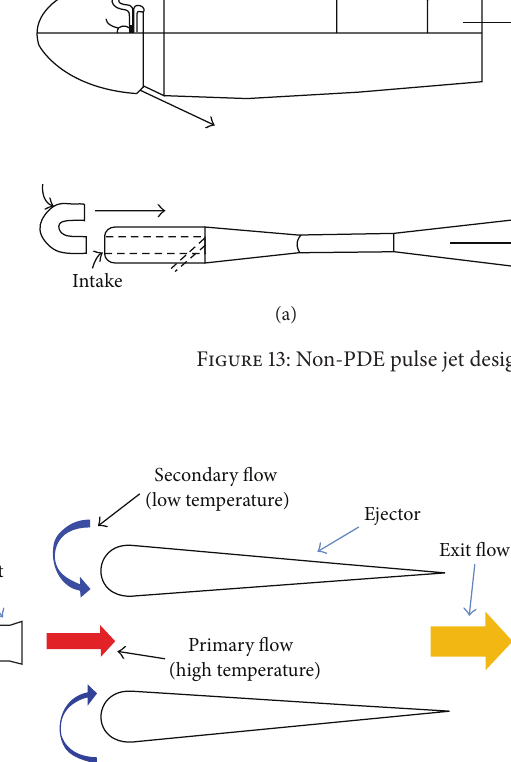
Figure 14: Combustion product mass flows through the ejectors